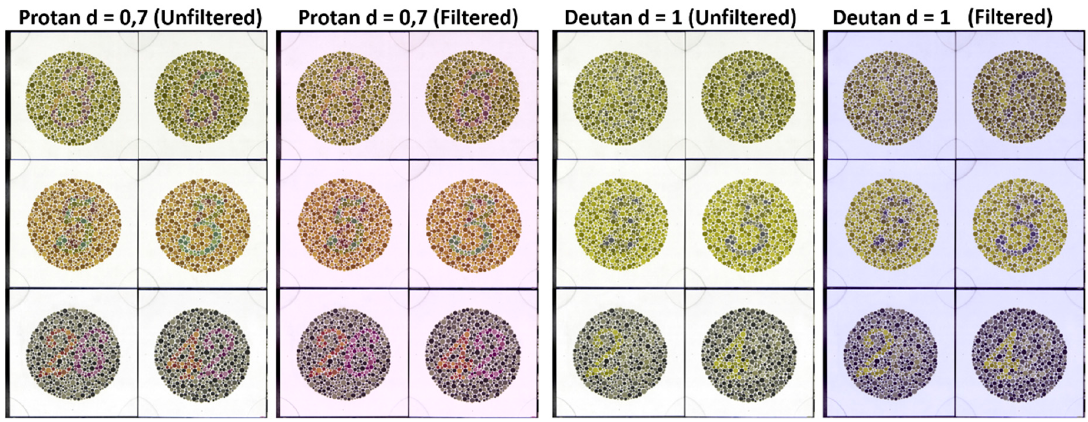
Figure 8. sRGB rendering of the Ishihara plates in dataset D3, for the protanomalous (left side) and deuteranopic (right side) simulated observers, for both unfiltered and filtered conditions.